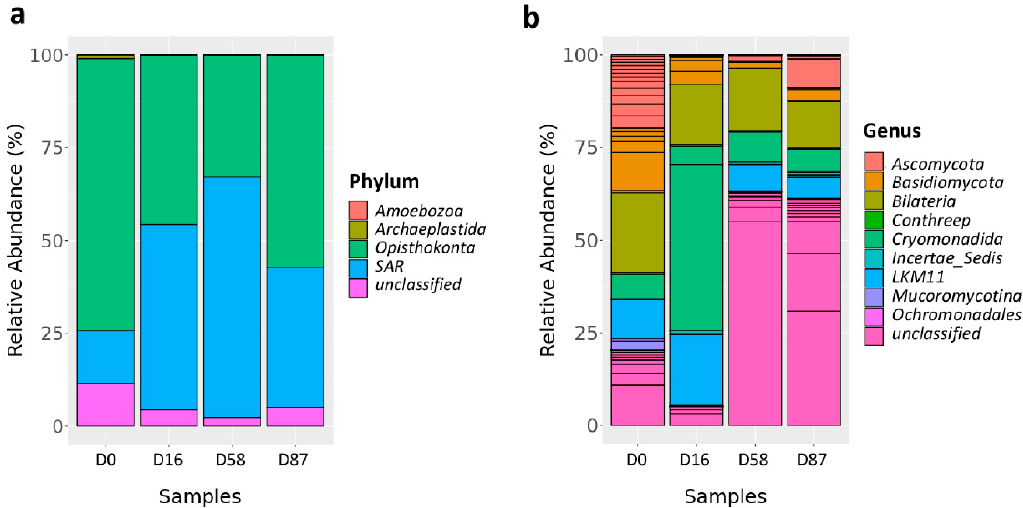
Figure 7. Metagenomic analysis of eukaryotic community. Distribution of the identified eukaryotes at the ( a ) phylum and ( b ) genus level, detected in four different timepoints. The scale in the y axis reflects the normalized relative abundance percentages (%). Black lines within each bar separates each Genus into lower taxonomic levels.